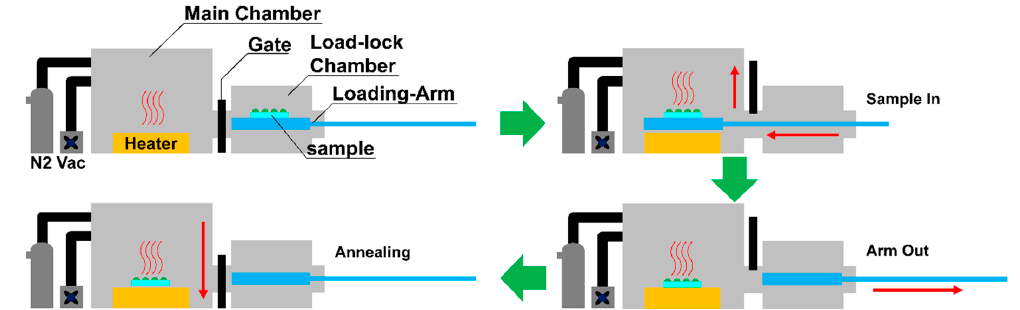
Figure 6. Schematic diagram of an annealing chamber for the annealing atmospheric conditions experiments of the QD EML pixel.